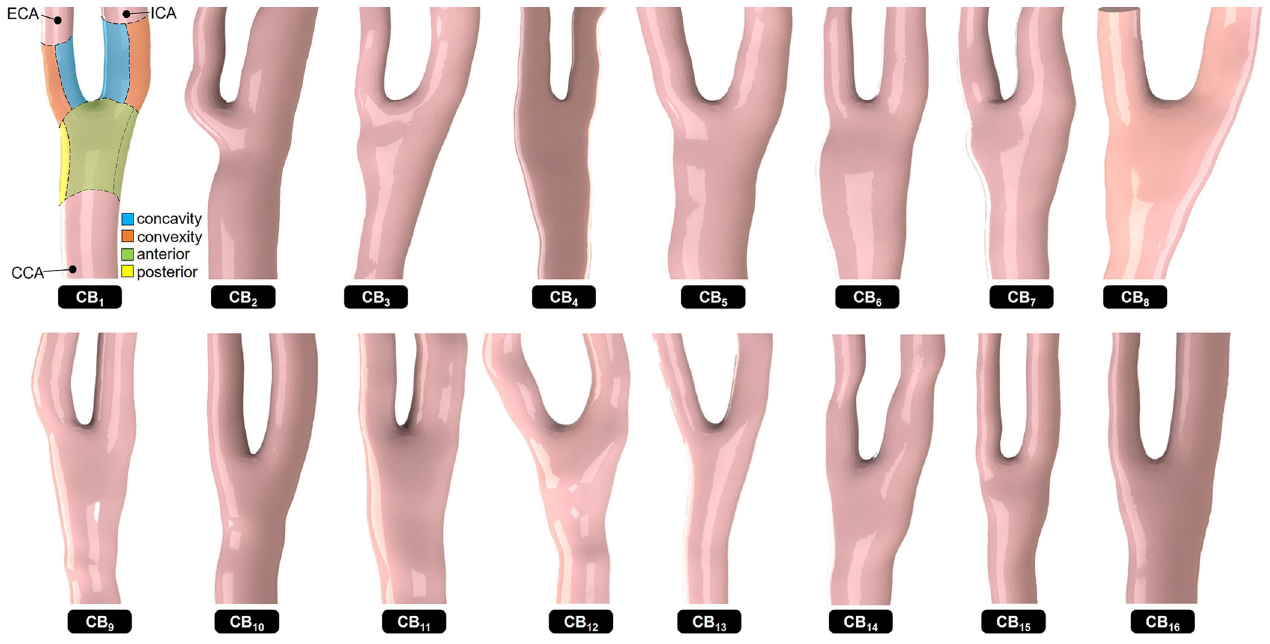
Fig. 6 Description of the 16 reconstructed carotid bifurcation geometrical models. In each model, WSS characteristics were probed in six regions of interest (as shown in model CB 1 ). Those include the posterior/anterior regions of the common carotid artery (CCA), and the concavity/convexity regions of the external carotid artery (ECA) and internal carotid artery